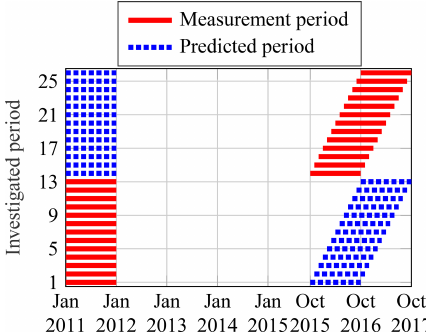
Figure 26. Visualisation of the 26 different periods for statistical evaluations in the context of long-term extrapolations.